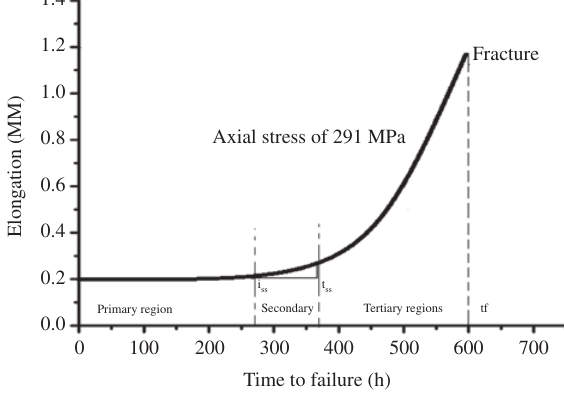
Figure 8: Relationship between applied stress and time to failure.